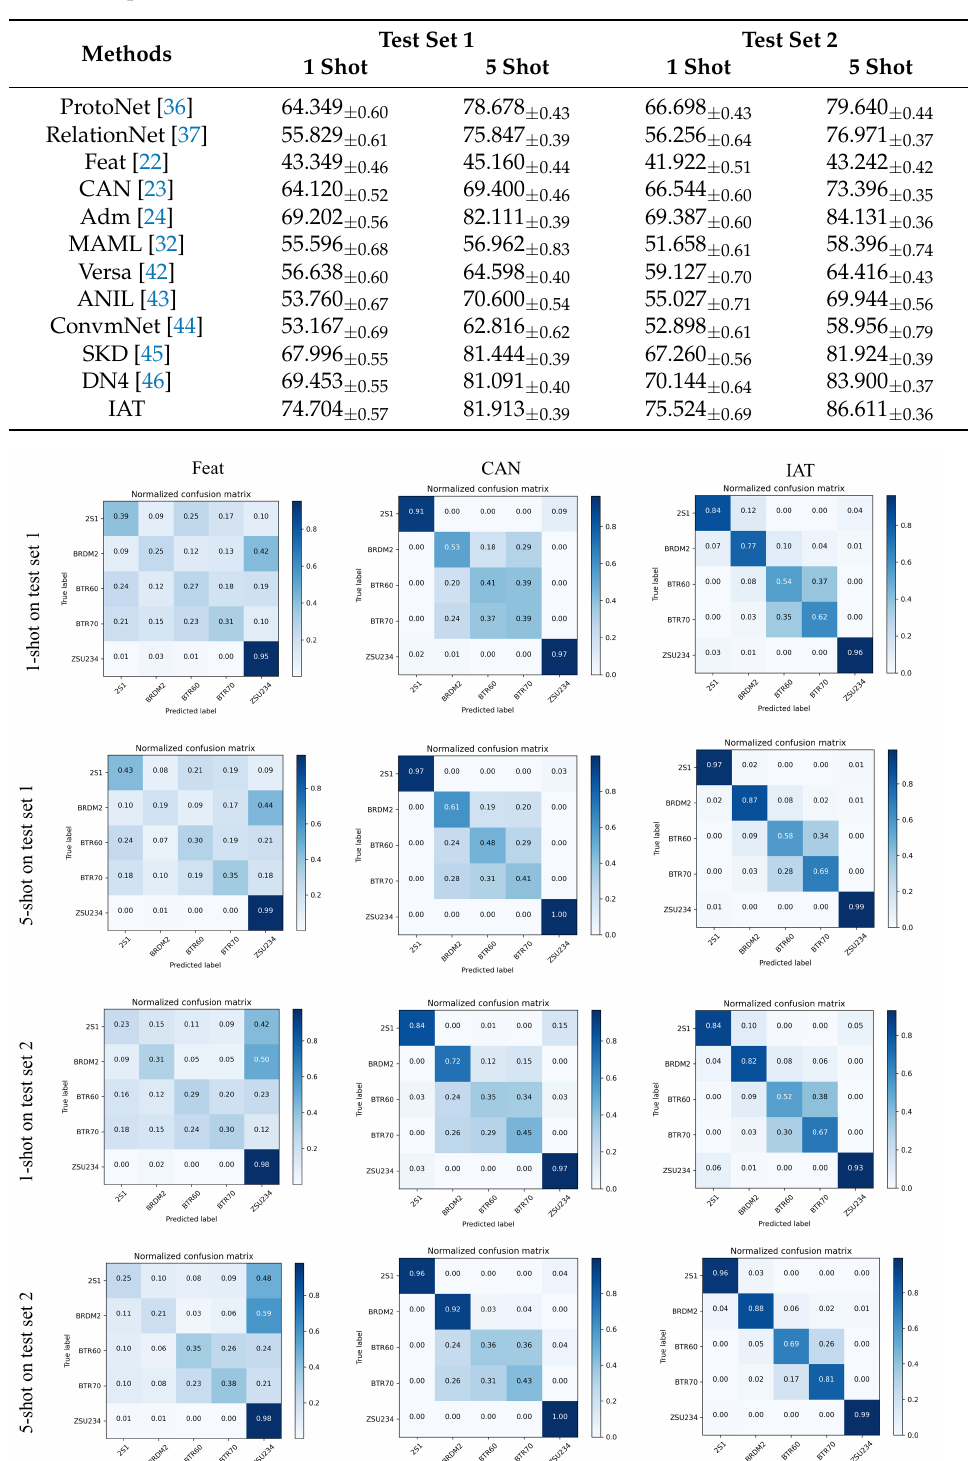
Table 2. Comparison with state-of-the-art methods on the two test sets. Accuracy and 95% confidence interval are presented on the two test sets.